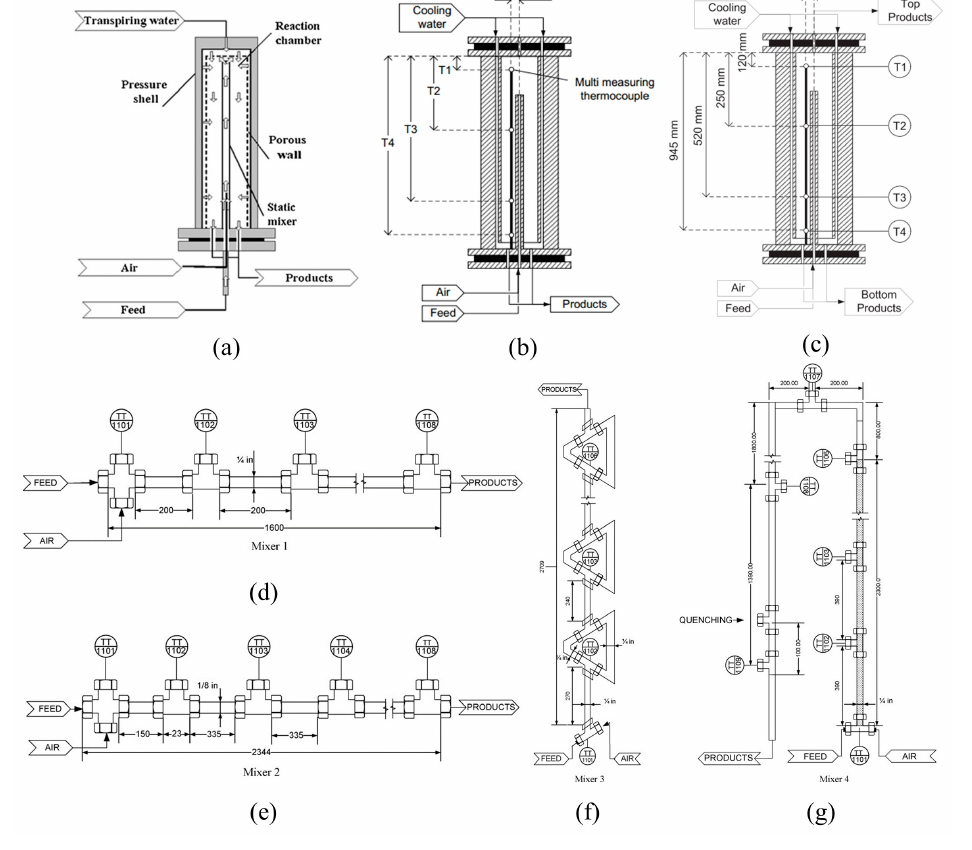
Figure 4. TWR and Mixers from the University of Valladolid (( a ) adapted from [74], ( b ) adapted from [75], ( c ) adapted from [37], ( d – g ) adapted from [30]).